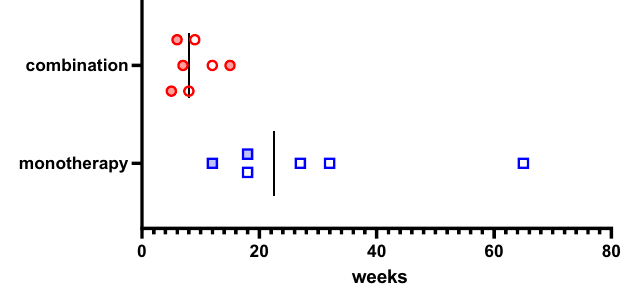
Figure 1. Time to develop secondary adrenal insufficiency (SAI) from initial injection of ICIs in 13 patients. In the combination therapy group, 7 patients developed secondary AI in a median time of 8 weeks during nivolumab and ipilimumab combination therapy. In the monotherapy group, 6 patients developed secondary AI in a median time of 22.5 weeks during nivolumab, pembrolizumab or ipilimumab monotherapy. In the combination therapy group, filled red circles show the timings of SAI diagnosis based on regular ACTH and cortisol tests, and open red circles show the timings of SAI diagnosis based on symptoms. In the monotherapy group, filled blue squares show the timings of SAI diagnosis during maintenance nivolumab monotherapy following the combination therapy, and open blue squares show the timings of SAI diagnosis during pembrolizumab or ipilimumab monotherapy without history of a combination